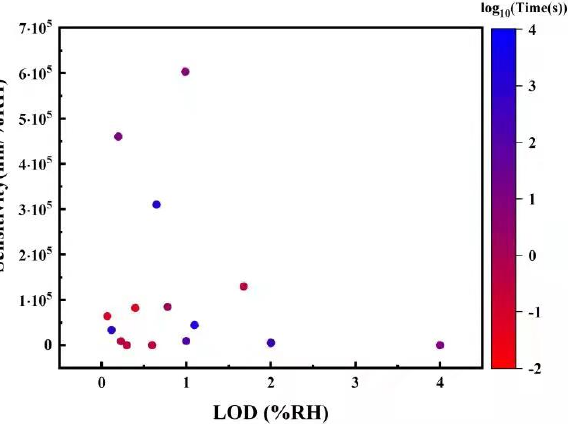
Figure 40. Relationship between limit of detection and sensitivity, with color representing log scale of time.